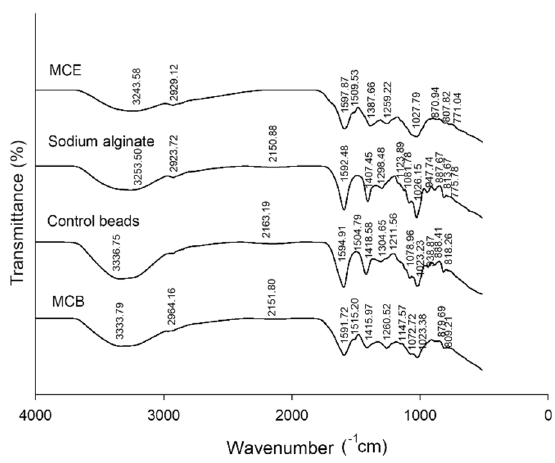
Figure 4. Fourier transform infrared spectroscopy (FT-IR) spectra of Mesona chinensis extract (MCE), sodium alginate, control beads, and Mesona chinensis beads (MCB).